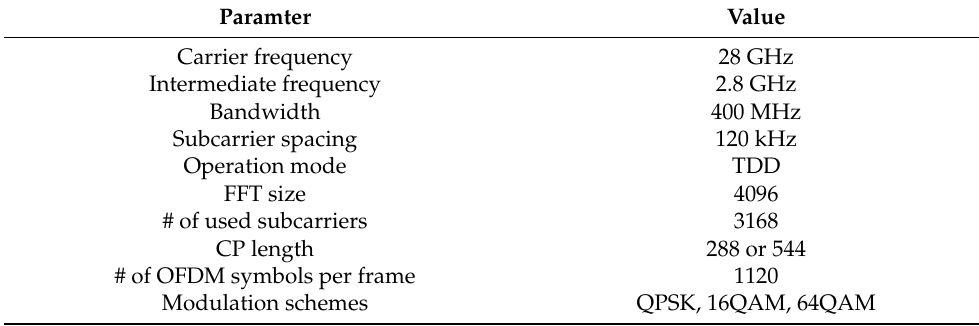
Table 1. System parameters